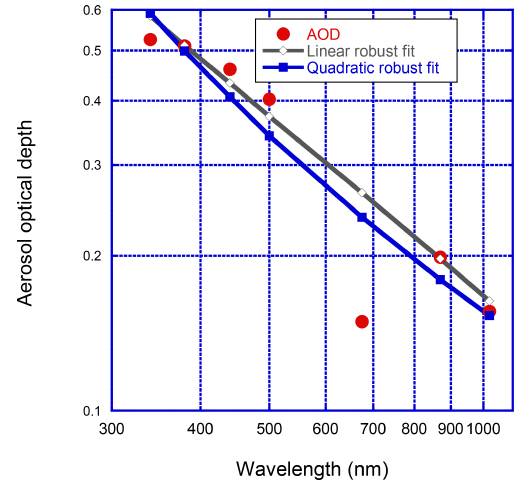
Figure 14. AERONET data from the Osaka (lat 34.65, long 135.59) site on 16 October 2006 at 22:02:11UTC. The plot shows AOD ver- sus the wavelength with lines identifying the linear and quadratic robust regression fits on a logarithmic scale used by the AOD spec- tral dependence algorithm. The 675nm channel is clearly anoma- lous with fits differing by 0.12 for linear fits and 0.09 for quadratic fits. In addition, the AOD at 340nm appears anomalous with de- viations of 0.06 from linear fit and 0.07 from quadratic fit. While both wavelengths exceed their respective AOD thresholds (0.023 for 675nm and 0.051 for 340nm), the algorithm determines the max- imum deviation for linear and quadratic fits and removes the AOD at 675nm measurement. A subsequent scan by the algorithm deter- mined that the remaining AOD measurements from 340 to 1020nm were within the established fit deviation